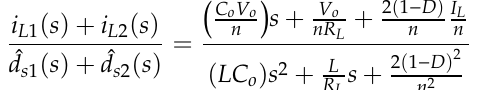
Figure 7. Inner current control loop schematic diagram.